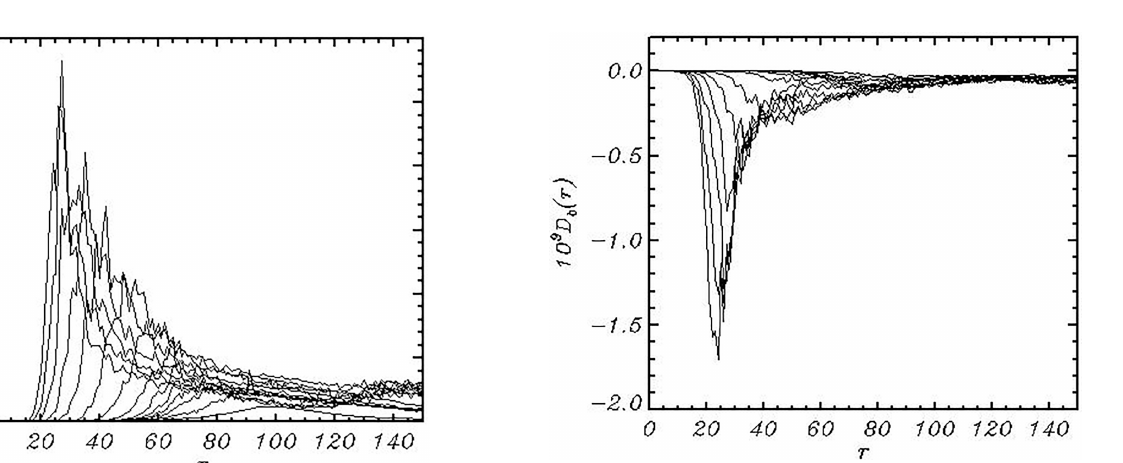
Figure 7. The spectrum of energy input I (r) integrated over angle ψ in the polar coordinates and averaged over the consequent inter- vals of length for about 100 units of the nondimensional time t .